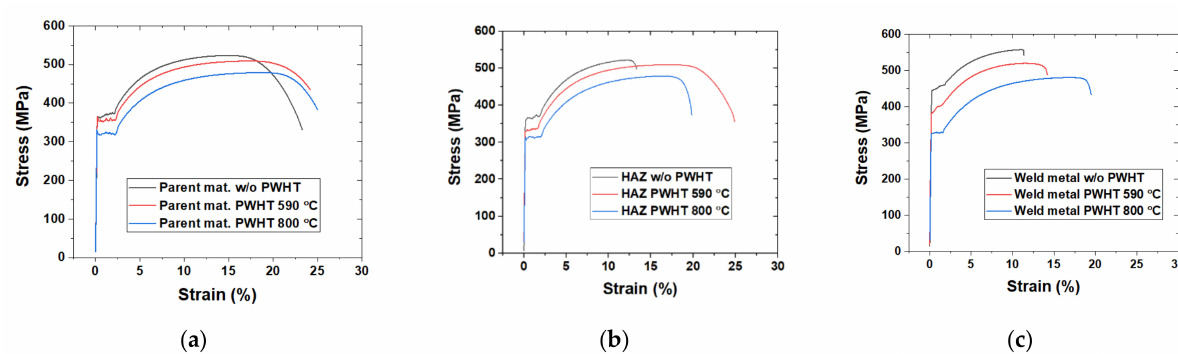
Figure 8. Strain-stress curve. ( a ) Parent material; ( b ) HAZ; and ( c ) weld metal.